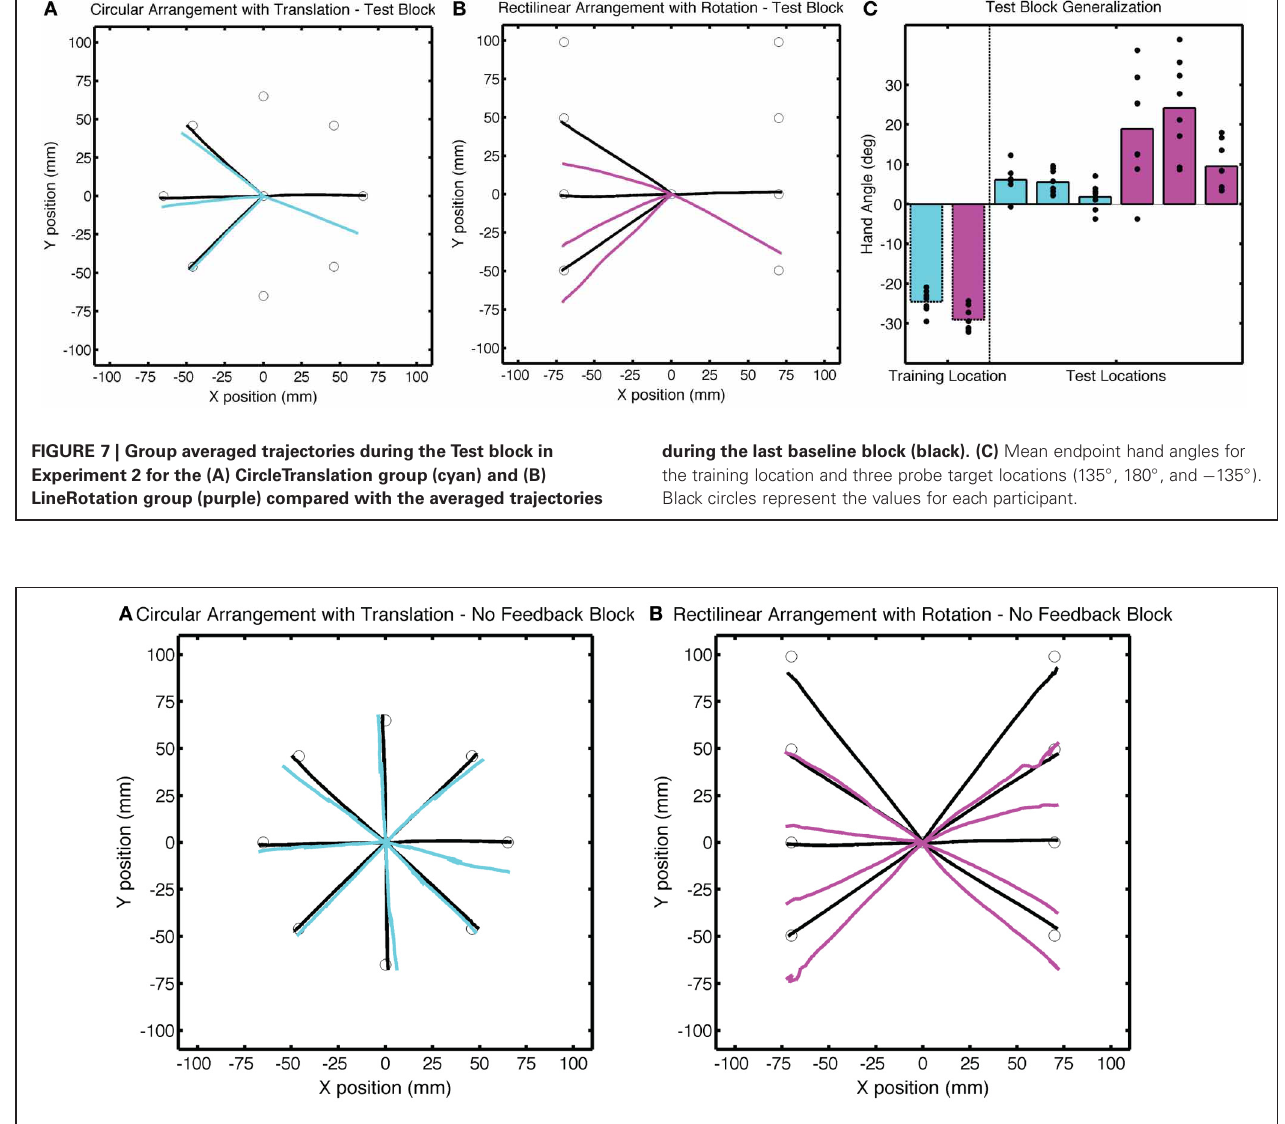
the averaged trajectories during the last baseline block (black). Movements to each target location were made without visual